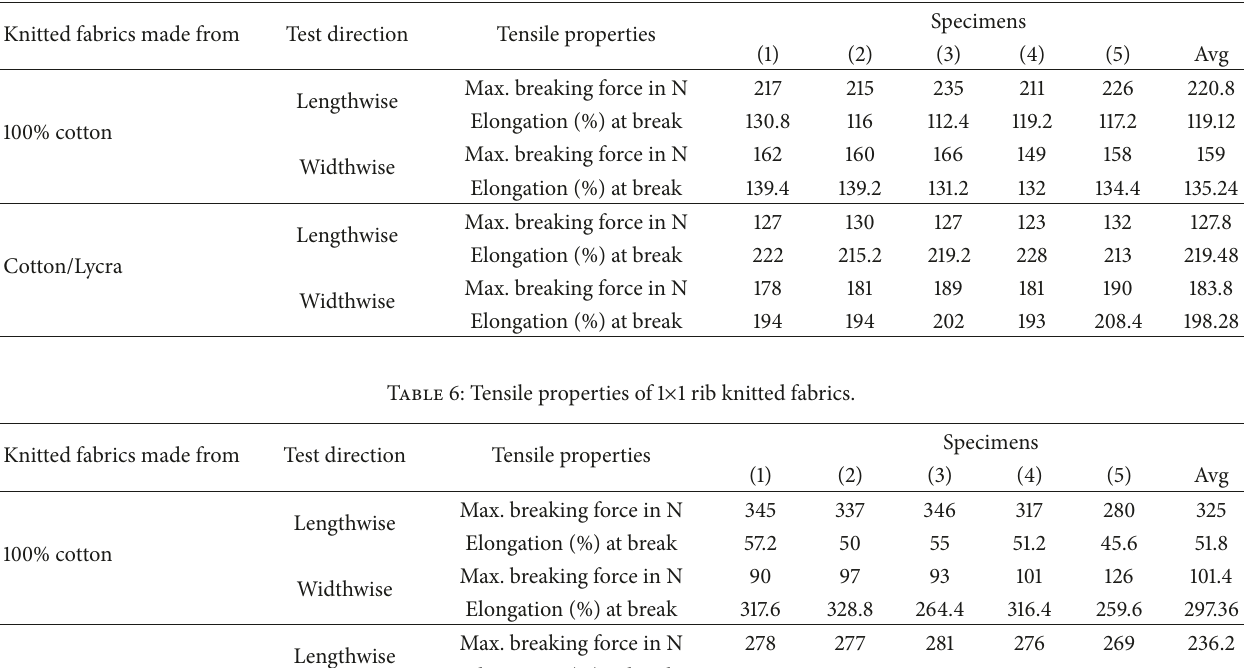
Table 5: Tensile properties of single jersey knitted fabrics.